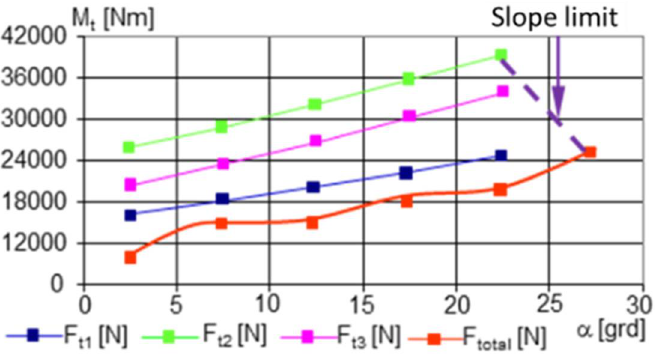
Figure 11. The variation in the necessary M t [ Nm ] as a function of the tilt angle of the